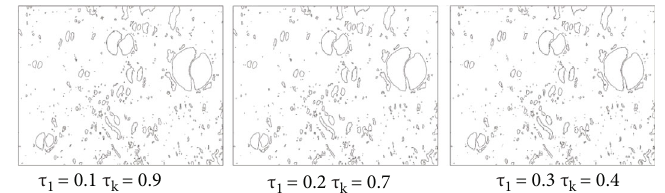
Figure 6: Canny detection results with various values of τ